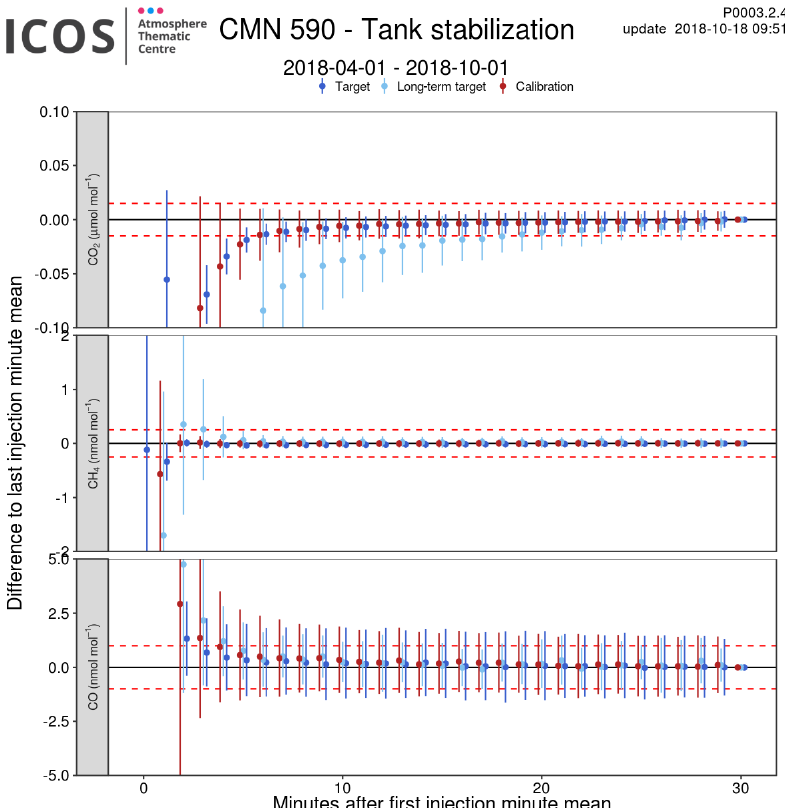
Figure 5. Difference between the last injection-minute-averaged data point and the rest of the injection for cylinder samples for Monte Cimone station (CMN) for instrument 590. All the injections over the last 6 months are averaged. Short-term target is in dark blue, long- term target in light blue and calibration in red. Dashed red lines show the thresholds. Vertical lines on each point show the minute standard